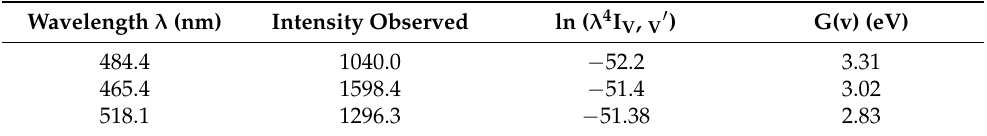
Figure 2. Boltzmann plot to calculate vibration temperature using electronic bands of AlO molecule and CaO molecule. Table 2. The intensity of the electronic bands of the AlO molecule to calculate the vibrational temperature (plasma temperature).